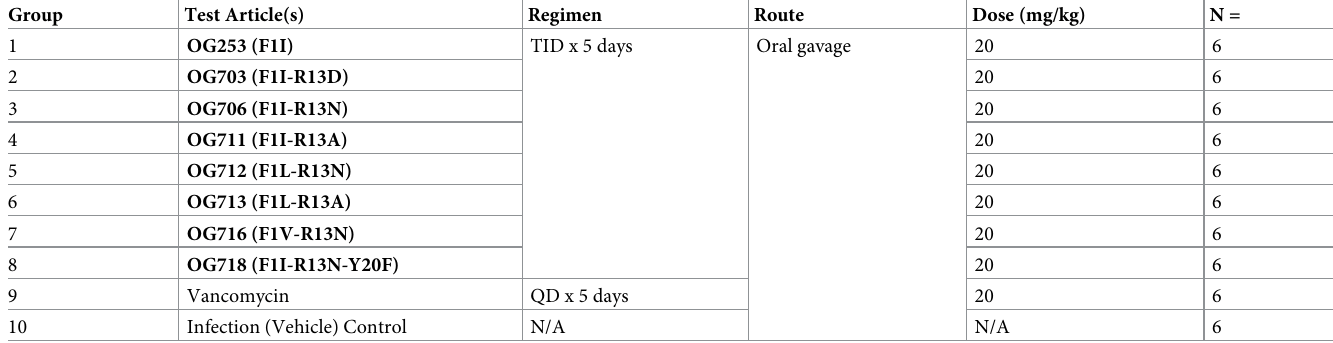
Table 2. Hamster CDAD study